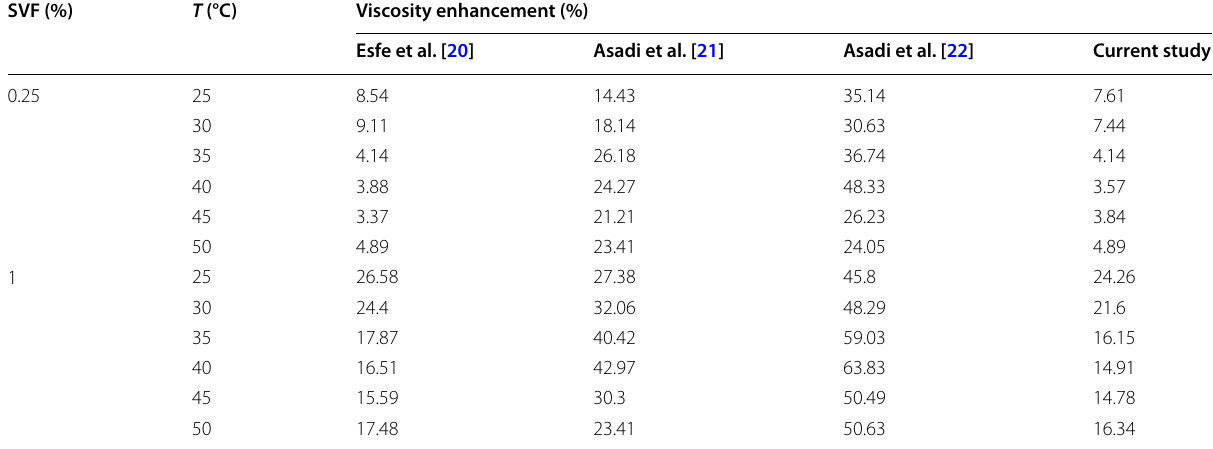
Table 8 Statistical comparison between the present study and similar research based on Fig. 11 SVF (%) T (°C) Viscosity enhancement (%) Esfe et al.